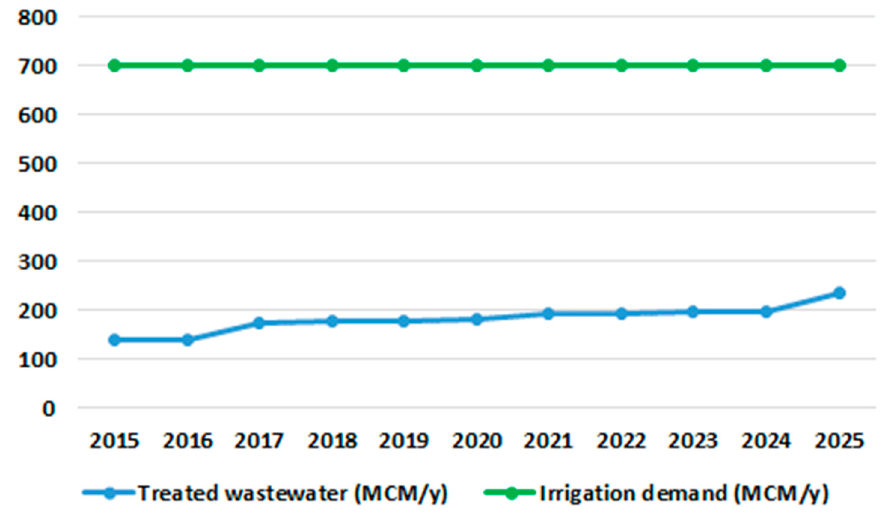
Figure 1. Projected treated wastewater generation and irrigation demand.